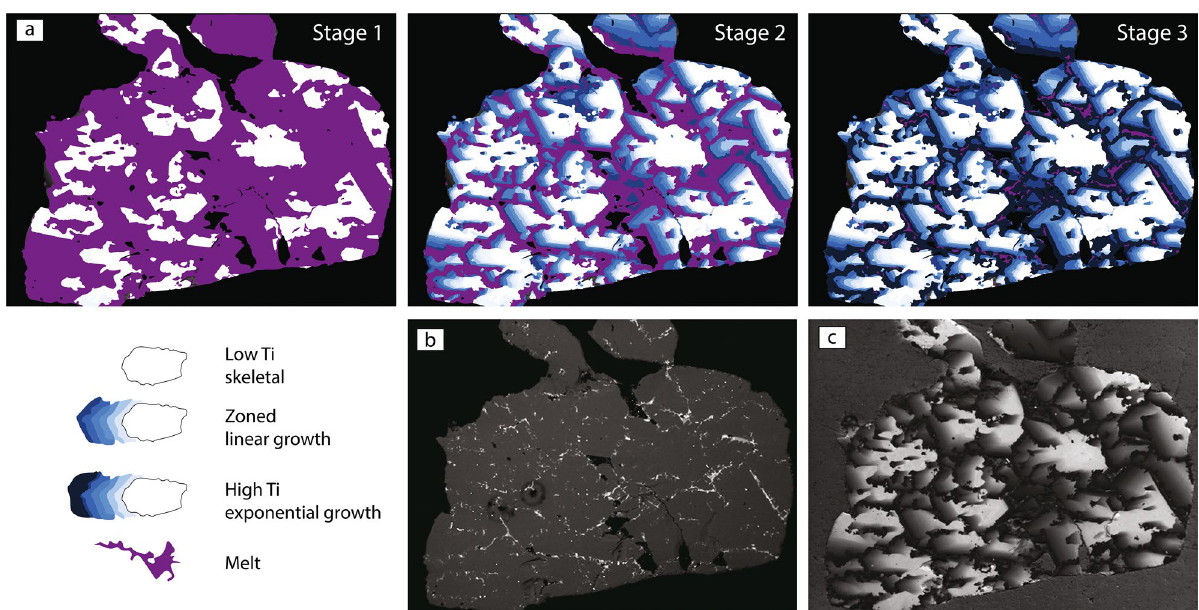
Figure 7. ( a ) Cartoon showing the distribution of corundum crystallized during the different stages of growth, in a crystal aggregate cut roughly subparallel to the C axes of the corundum. Aggregate is 2 mm long. ( b ) BSE image in which corundum is dark grey, void spaces are black, and melt pockets are highlighted by white crystals in grey glass. ( c ) Cathodoluminescence image (real colour of light areas is bright pink). In some white areas it is possible to see very skeletal structures, some surrounded by hopper walls with oscillatory zoning, perhaps suggesting relatively rapid